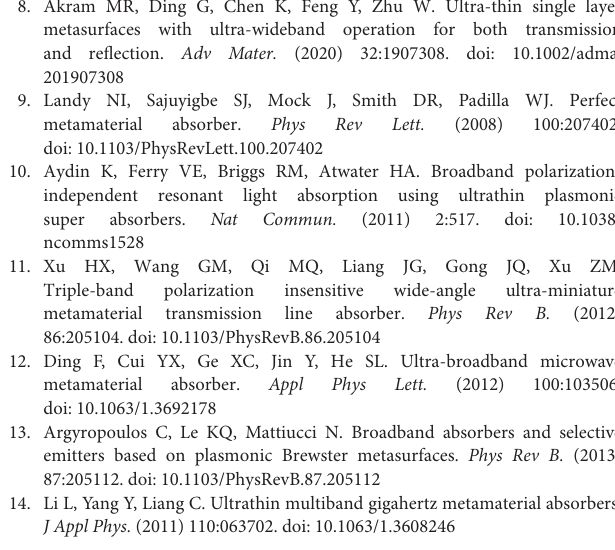
polarization angles is the same due to the rotational symmetry of the unit